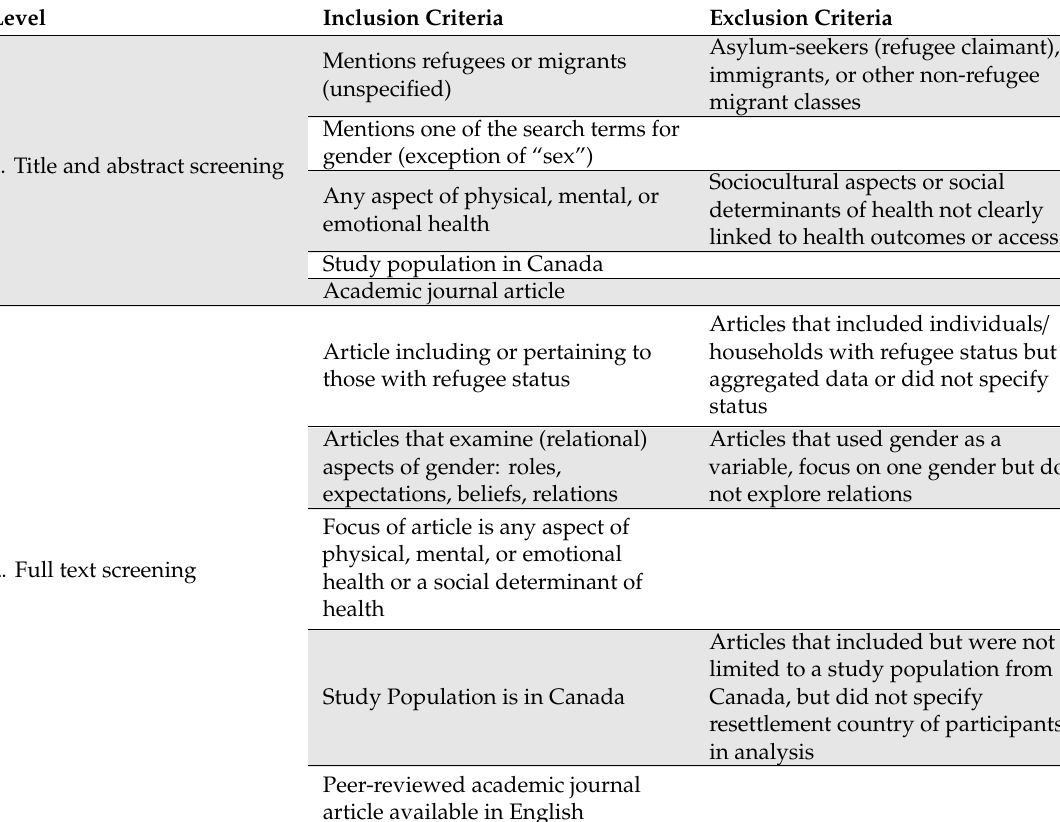
Table 2. Inclusion / exclusion criteria for levels 1 and 2